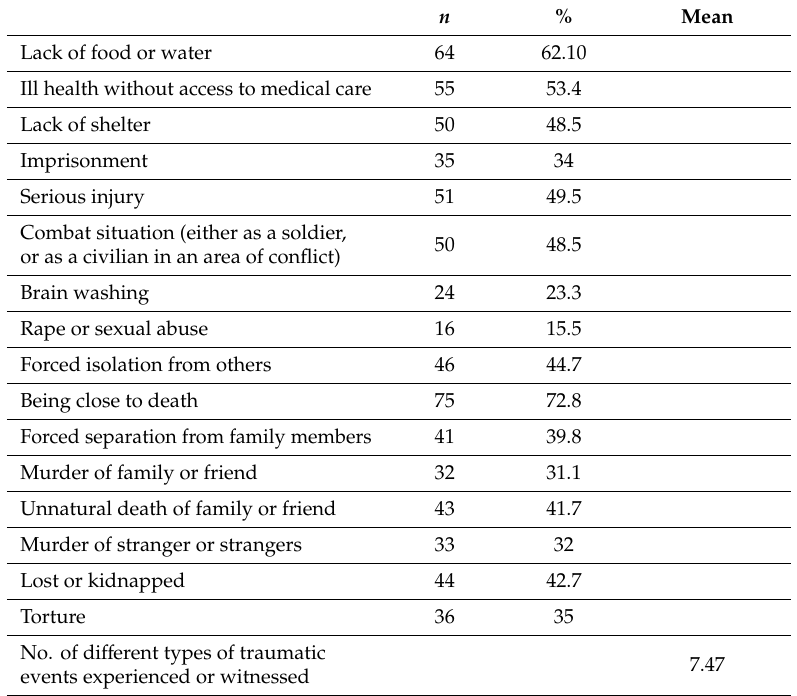
Table 2. Frequencies of trauma exposure based on responses to the Harvard Trauma